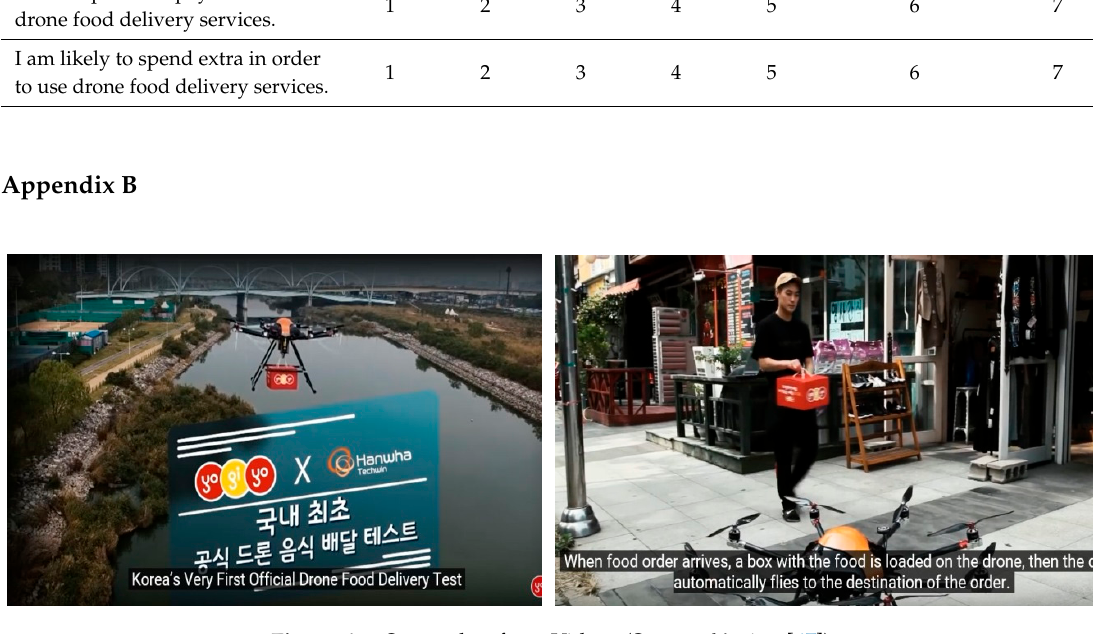
Figure A1. Screenshot from Videos (Source: Yogiyo [67]).